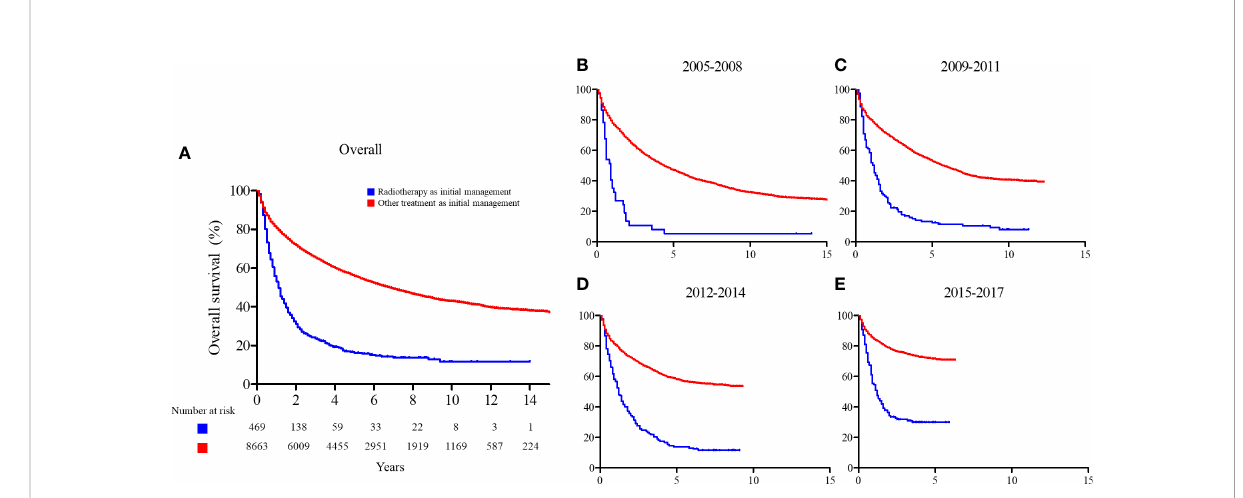
FIGURE 4 Overall survival comparison between patients who received radiotherapy as initial management and those who did not. (A) Entire cohort; (B) patients enrolled between 2005 and 2008; (C) patients enrolled between 2009 and 2011; (D) patients enrolled between 2012 and 2014; and (E) patients enrolled between 2015 and